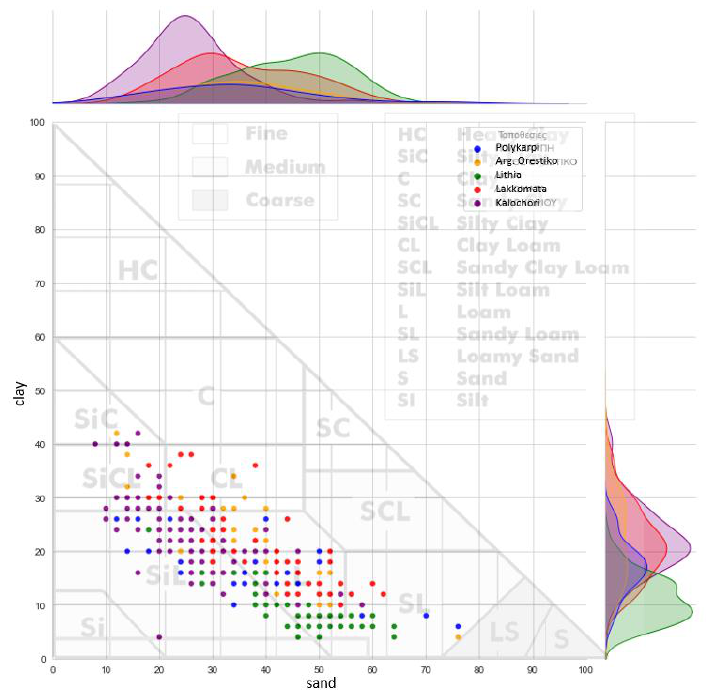
Figure 8. Distribution of soil samples on texture triangle (different colors correspond to major sub- regions of Kastoria). subregions of